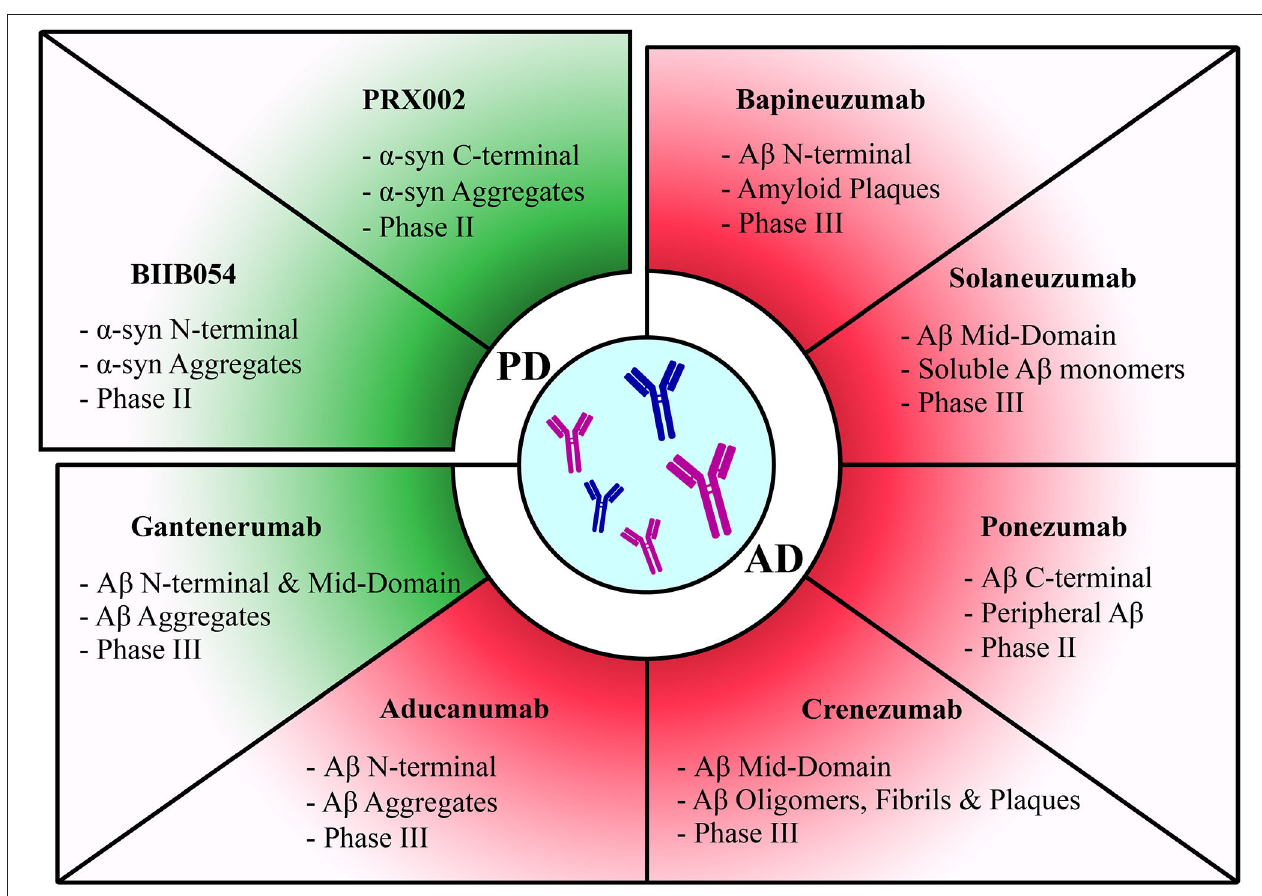
FIGURE 2 | Summary of passive immunization therapies assessed in clinical trials for different diseases. Discontinued trials highlighted in red and ongoing trials highlighted in green. Therapies have been categorized according to each pathology they target. The target of each therapy along with its current clinical trial phase have been stated for each